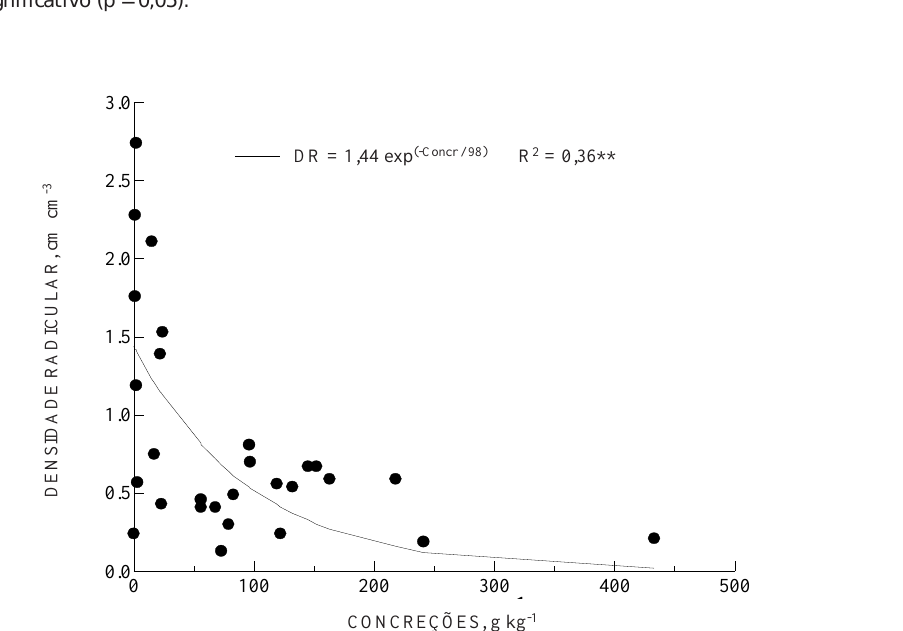
(1) Saturação por alumínio. (2) Microporosidade. (3) Macroporosidade. (4) Porosidade total. (5) Densidade do solo (Ds). (6) Resistência